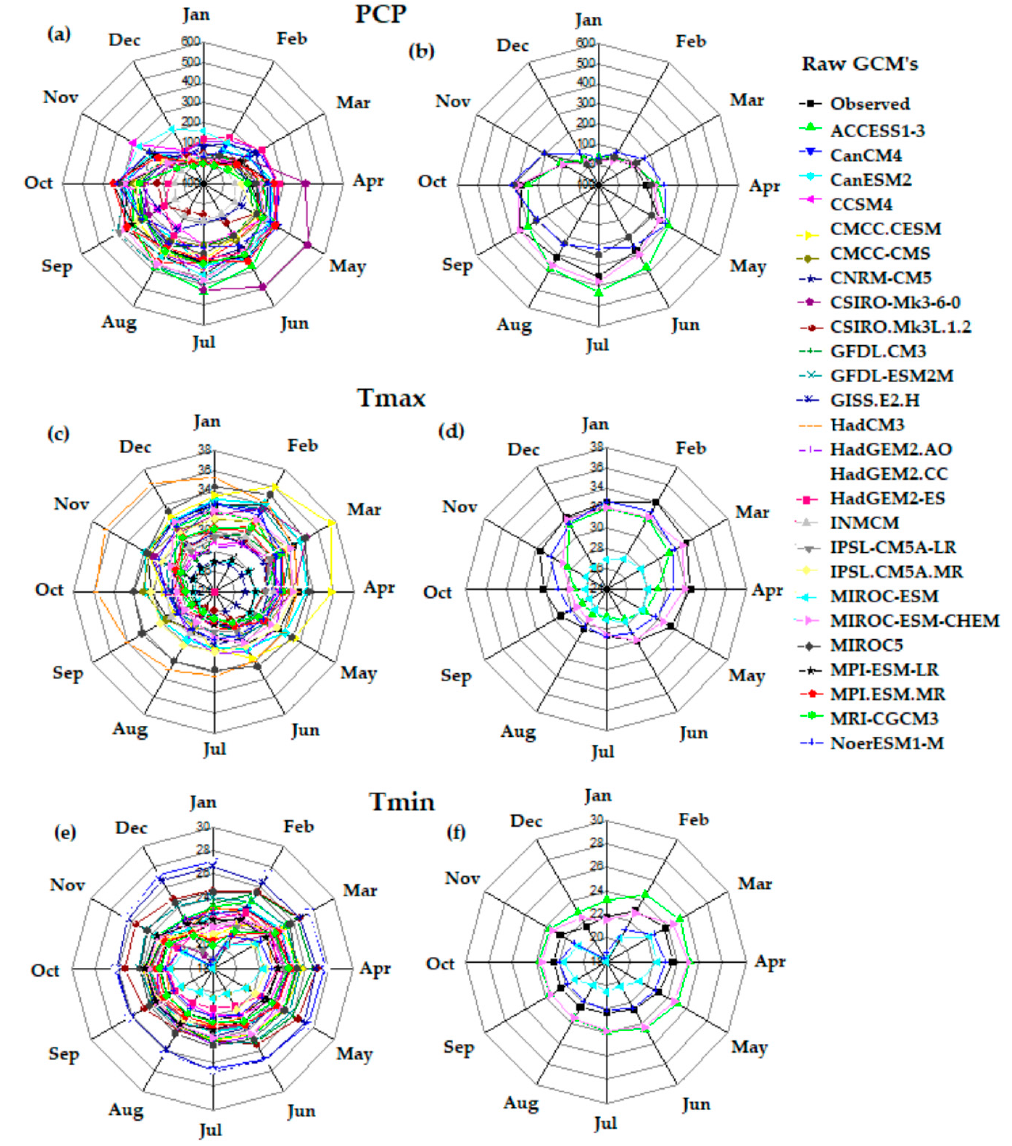
Figure 3. Monthly averages of CRU and raw datasets. ( a ) 26 Prcp, ( b ) 4 Prcp SU, ( c ) 26 Tmax, ( d ) 4 Tmax SU, ( e ) 26 Tmin, and ( f ) 4 Tmin SU GCM outputs for the historical period 1980–2005 at the grid point located in Port Harcourt.